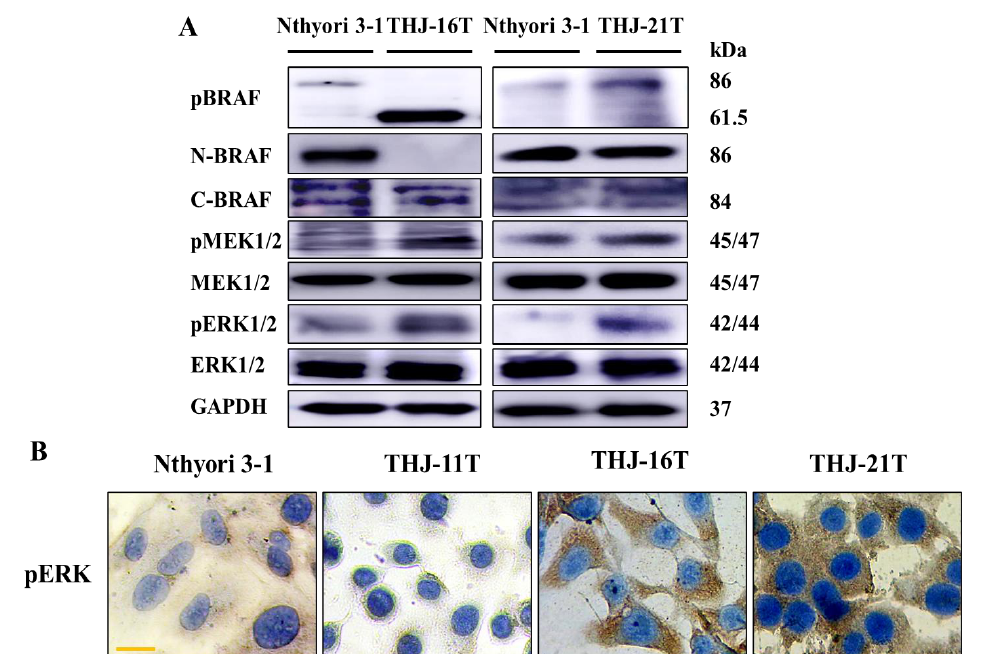
Figure 4. Differential expression of pBRAF, BRAF, pMEK, MEK, pERK, ERK in Nthyori 3-1, THJ-11T, THJ-16T, and THJ-21T cells. ( A ) Western blotting analyses of pBRAF, BRAF, pMEK, MEK, pERK, and ERK levels in Nthyori 3-1, THJ-16T, and THJ-21T cells. GAPDH served as a loading control. ( B ) Immunocytochemical staining (scale bar, 5 μ m) of pERK performed on Nthyori 3-1, THJ-11T, THJ-16T, and THJ-21T cells.